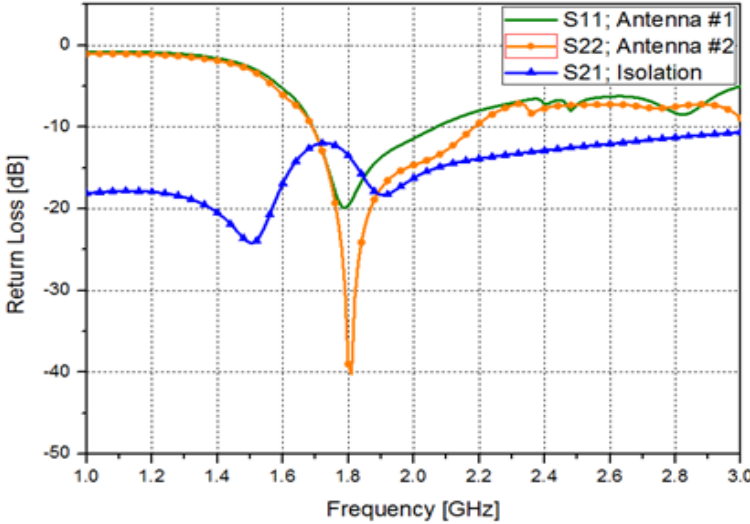
Figure 2. Simulated S-parameters of the designed antennas; return loss of the first antenna (S 11 ), return loss of the second antenna (S 22 ), and isolation between two antennas (S 21 ).